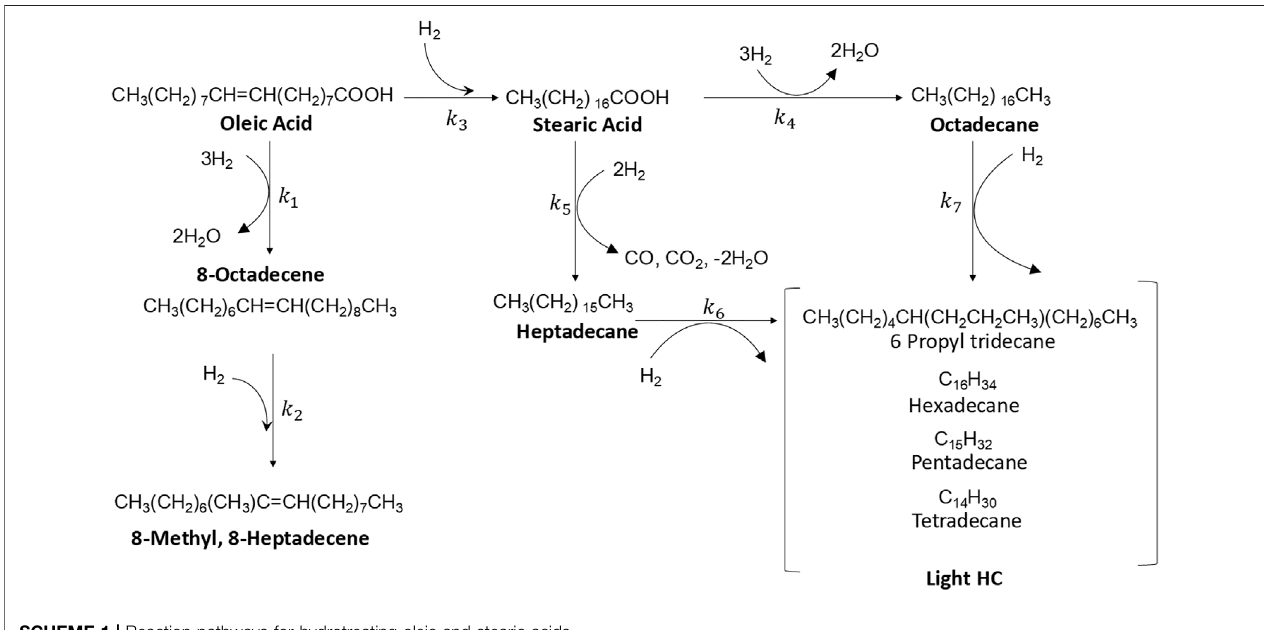
SCHEME 1 | Reaction pathways for hydrotreating oleic and stearic acids.